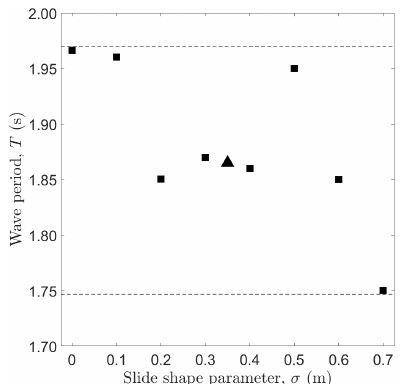
Figure 8. Wave periods observed at x = 1 m under slides with various slide shape parameter σ . (cid:4) : results of model slides shown in Figure 6. (cid:78) shows the baseline result by the solid slide used in the physical modeling. Dashed lines indicate the ± 6%